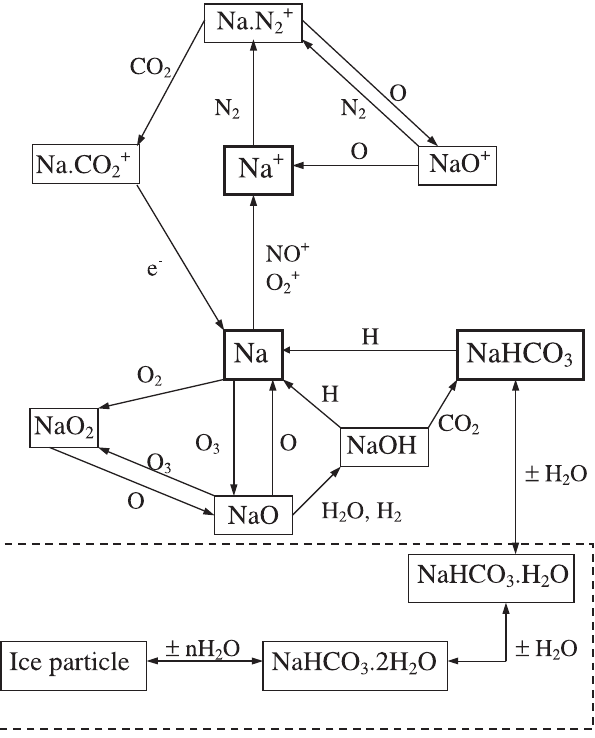
Fig. 1. Schematic drawing of the important chemistry of sodium in the upper mesosphere (NaO sake of clarity). The major sodium species are in the thick-edged boxes . The cluster reactions between NaHCO proposed to occur at the cold summer mesopause, are surrounded by the dashed